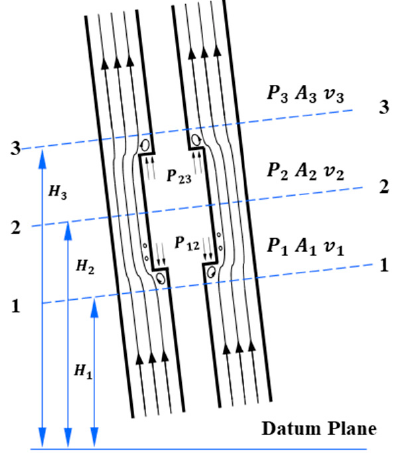
Figure 1. Schematic diagram of drilling fluid flow at the tool joint.